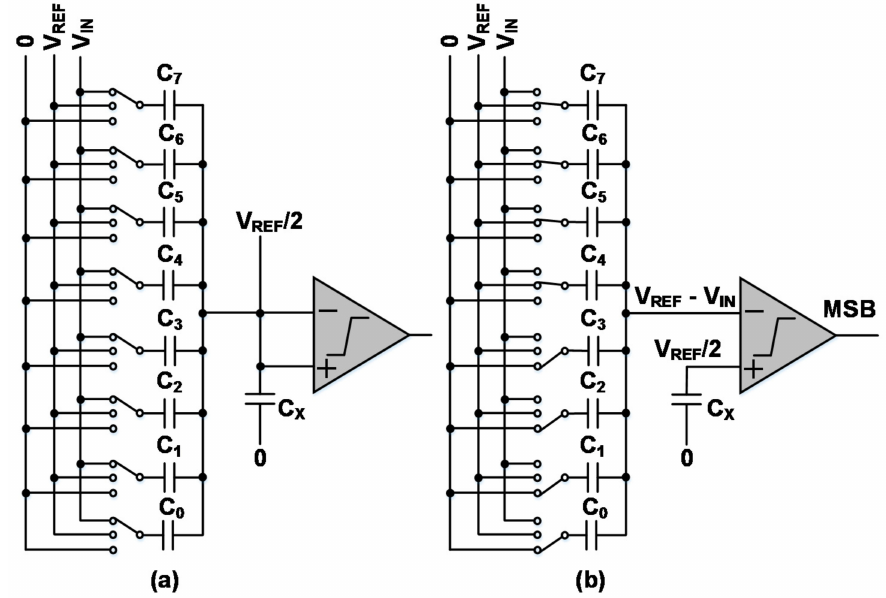
Figure 7. CDAC switching in ( a ) Sampling and ( b ) holding. CDAC: capacitor digital to analog